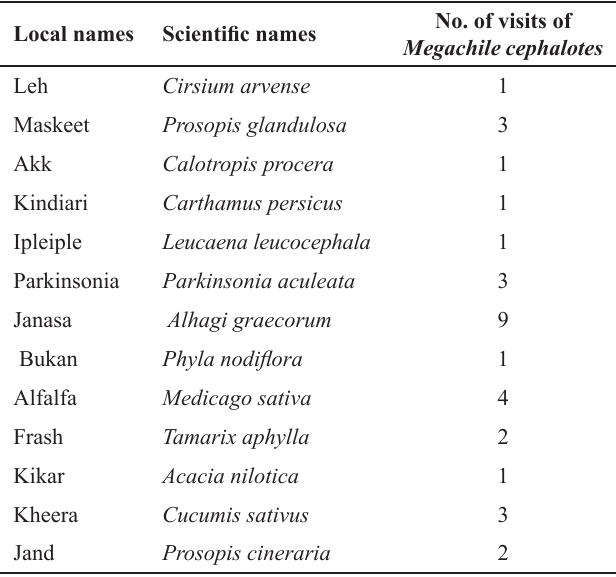
No. of visits of